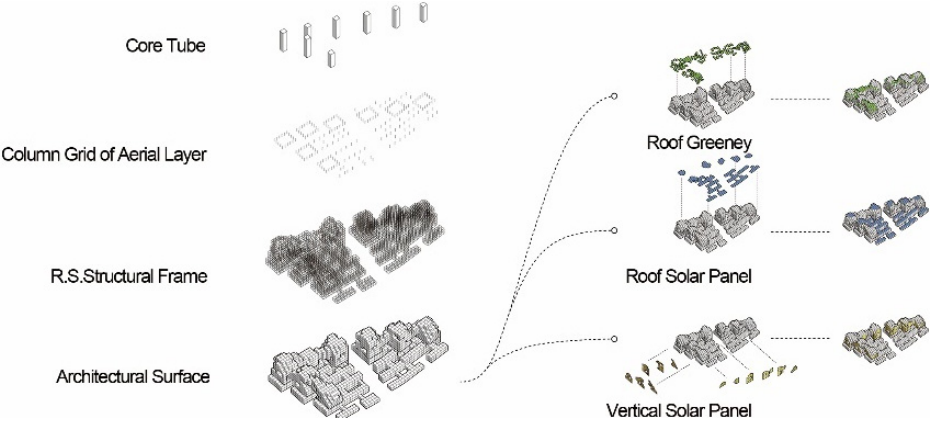
Figure 15. Spatial relationships between greening facilities and buildings (Source: author).